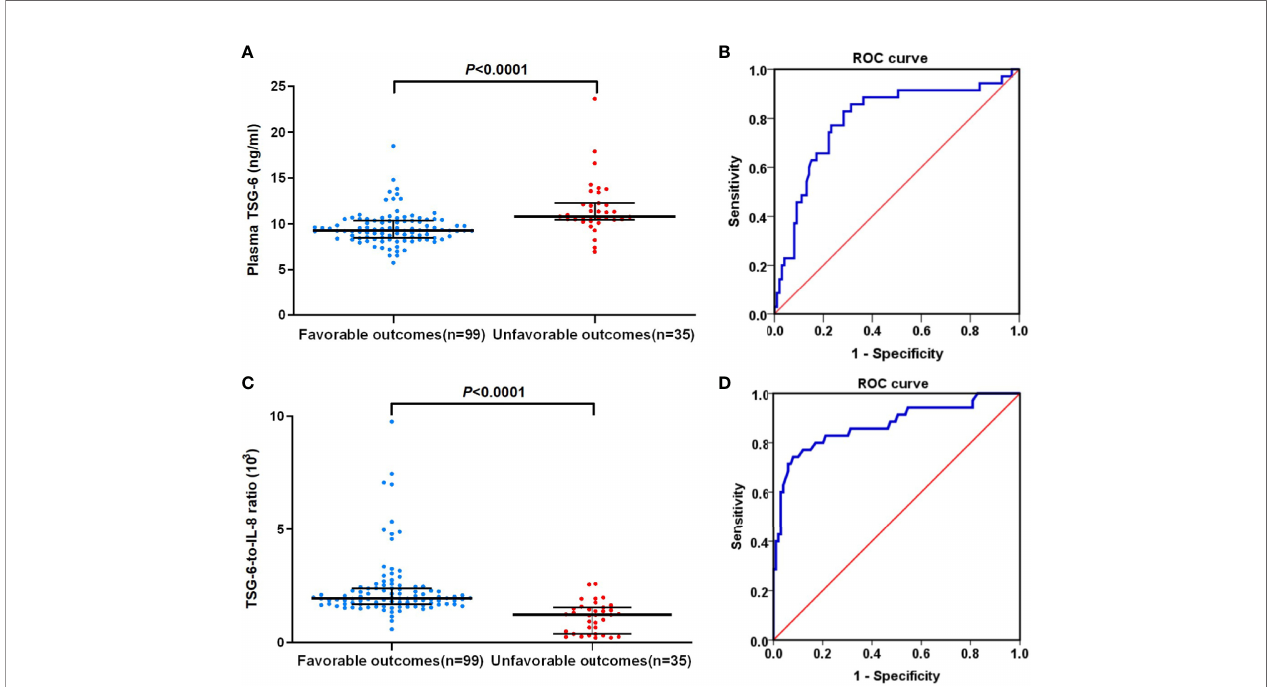
FIGURE 4 | (A) Plasma TSG-6 levels between favorable outcome and unfavorable outcome groups in non-cardioembolic AIS. (B) The ROC curve of plasma TSG-6 concentration for predicting 3-month prognosis of non-cardioembolic AIS. The AUC value is 0.795 (95% CI, 0.702 – 0.887; P < 0.0001). (C) TSG-6-to-IL- 8 ratios between favorable outcome and unfavorable outcome groups in non-cardioembolic AIS. (D) The ROC curve of TSG-6-to-IL-8 ratio for predicting 3-month-prognosis of non-cardioembolic AIS. The AUC value is 0.873 (95% CI, 0.795 – 0.951; P < 0.0001). The horizontal lines indicate median levels and interquartile ranges. P -values determined by the Mann – Whitney U test. AIS, acute ischemic stroke; TSG-6, tumor necrosis factor-stimulated gene-6; IL-8, interleukin-8; ROC, receiver-operator